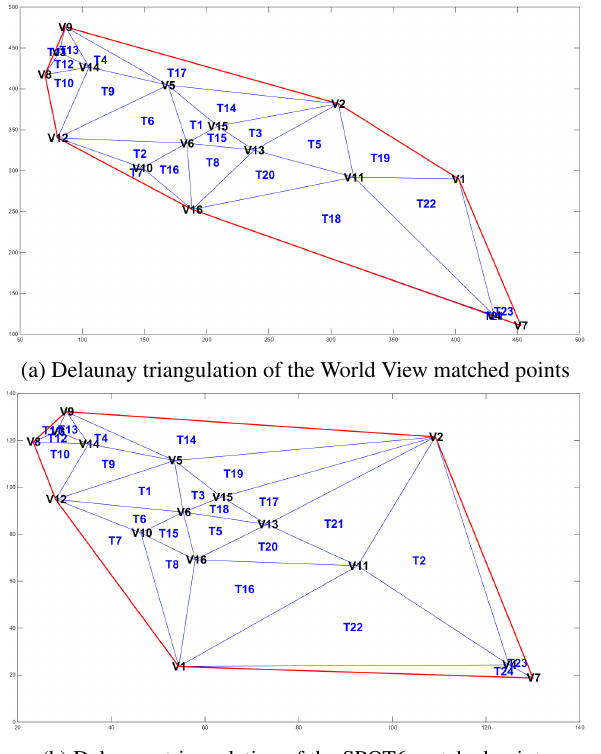
Figure 4: Delaunay triangulations of the matched points on both World View and SPOT6 patch number seven for distance thresh- old of 2.5. The labels are shown in the same way like in Figure 3. Note how different look the two triangulations with only two false positives out of 16 points in total.